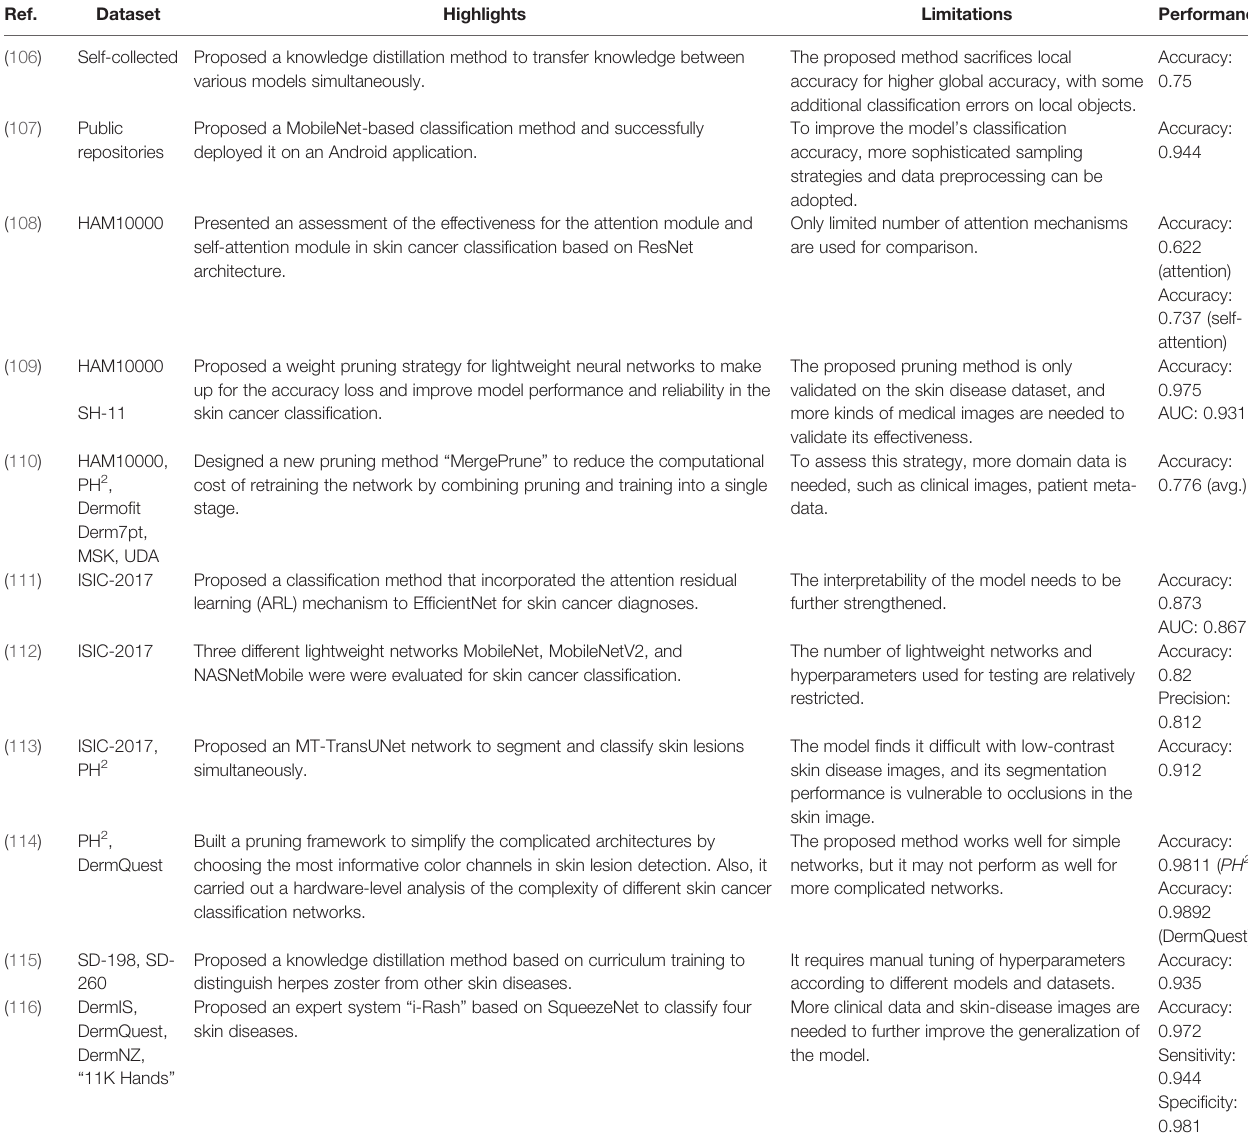
TABLE 6 | Different methods for improving model ef fi ciency.